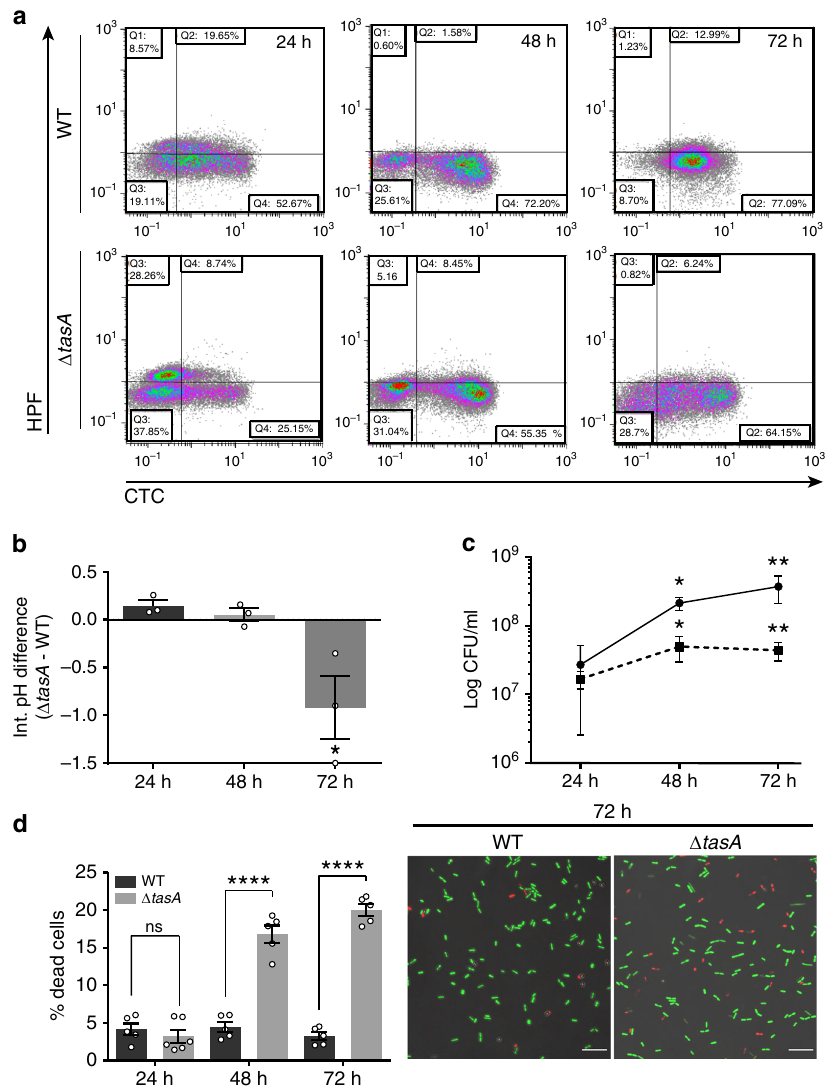
Fig. 4 Respiration rates and cell viability are compromised in Δ tasA cells. a Flow cytometry density plots of cells double stained with the HPF (Y axis) and CTC (X axis) dyes show that Δ tasA cells were metabolically less active (lower proportion of cells reducing CTC) and were under oxidative stress as early as 24 h (higher proportion of HPF-stained cells). b Measurements of intracellular pH show signi fi cant cytoplasmic acidi fi cation in the Δ tasA cells at 72 h. Average values of four biological replicates are shown. Error bars indicate the SEM. Statistical signi fi cance was assessed by one-way ANOVA with Tukey multiple comparison test (* p < 0.05). c The population dynamics in Δ tasA (dashed line) and WT colonies (solid line) grown on MSgg agar at 30 °C showed a difference of nearly one order of magnitude in the Δ tasA colony from 48 h. Average values of three biological replicates are shown. Error bars represent the SEM. Statistical signi fi cance was assessed by two-sided independent t -tests at each time point (** p value = 0.0084 * p value = 0.0410). d Left. Quanti fi cation of the proportion of dead cells treated with the BacLight LIVE/DEAD viability stain in WT and Δ tasA colonies at different time-points reveled a signi fi cantly higher population of dead cells at 48 h and 72 h in Δ tasA colonies compared to that found in the WT colonies. N = 5 colonies of the corresponding strains examined over three independent experiments. Average values are shown. Error bars represent the SEM. For each experiment and sample, at least three fi elds-of-view were measured. Statistical signi fi cance was assessed via two-tailed independent t -tests at each time-point (**** p < 0.0001). Right. Representative confocal microscopy images of fi elds corresponding to LIVE/DEAD-stained WT or Δ tasA samples at 72 h. Scale bars = 10 µ m. Source data are provided as a Source Data fi